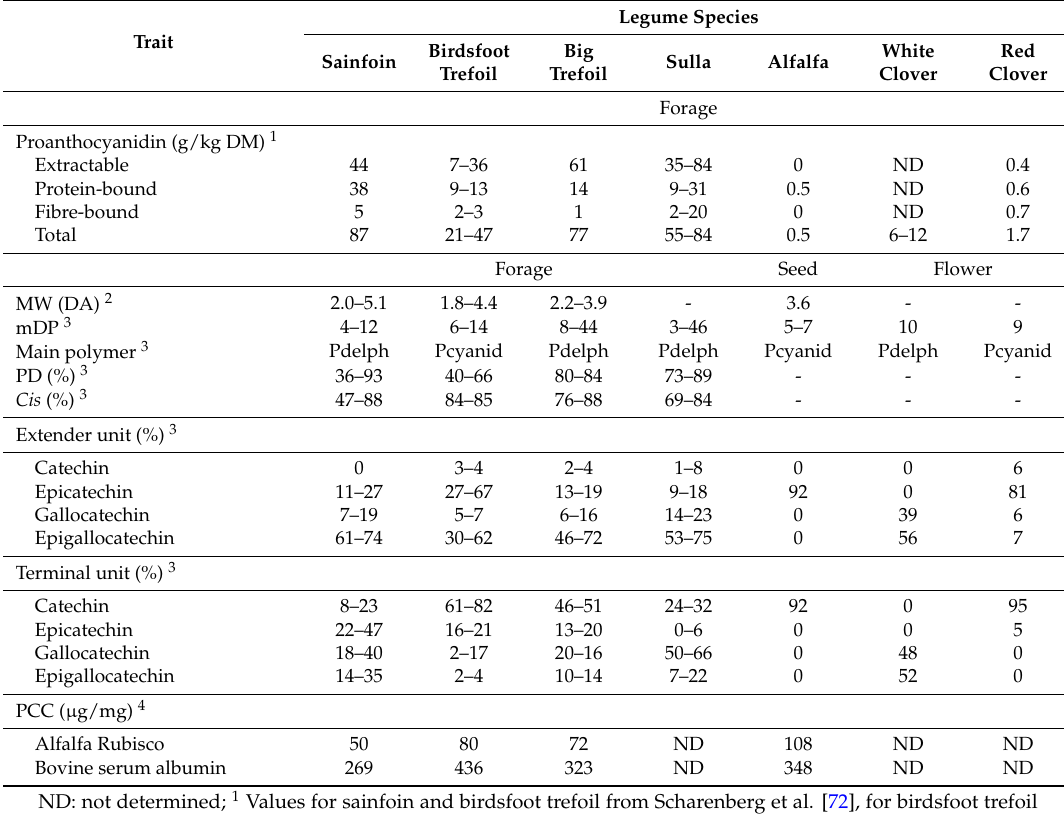
Table 1. Proanthocyanidin concentration, structure and protein precipitating capacity of several temperate forage